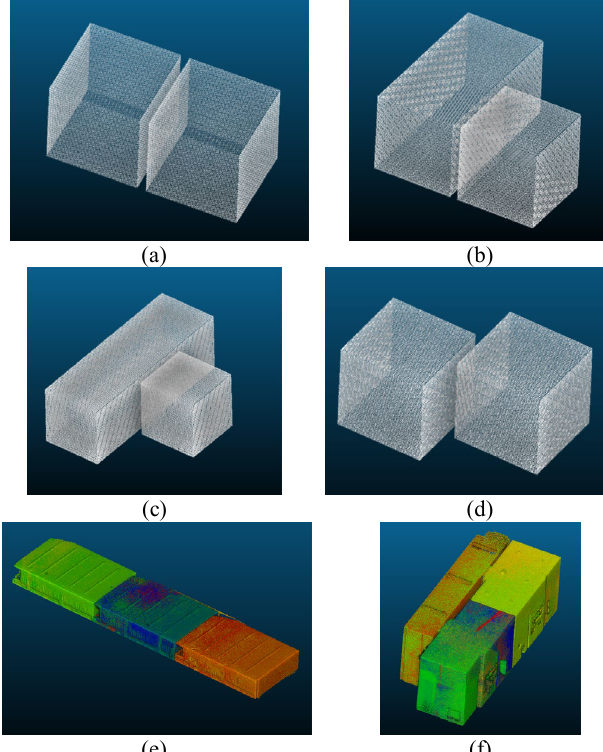
Figure 9. Scenarios: (a), (b), (c) and (d), synthetic scenarios; (e) and (f) real scenarios.